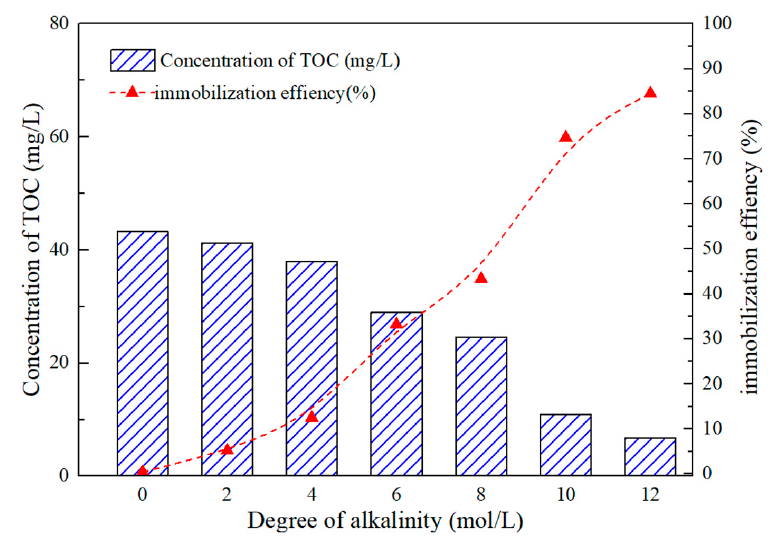
Figure 7. The concentration of TOC in the leachate and the organics immobilization efficiency of geopolymers synthesized with different alkali activator.